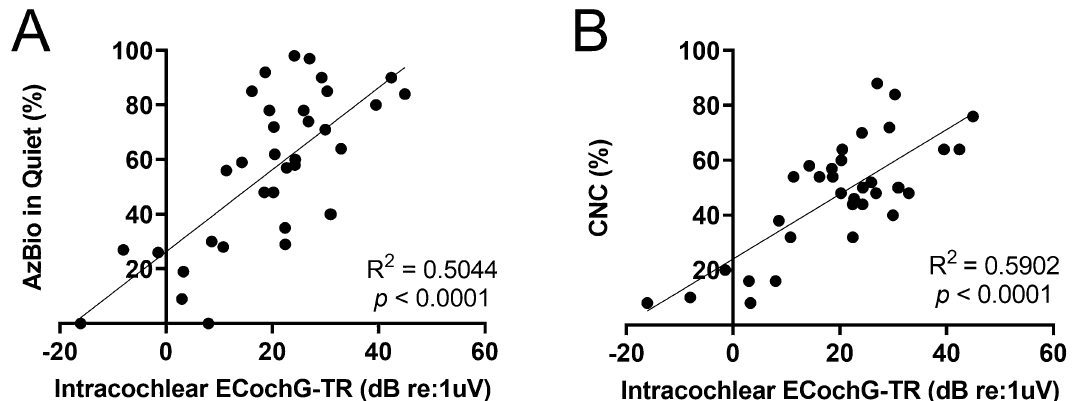
Figure 4. Univariate regression shows a moderate-to-strong linear correlation between performance in quiet and intracochlear electrocochleography total response (ECochG-TR). ( A ) Linear regression between ECochG-TR and AzBio in Quiet shows a moderate correlation, and ( B ) Linear regression between ECochG-TR and CNC shows a strong correlation.